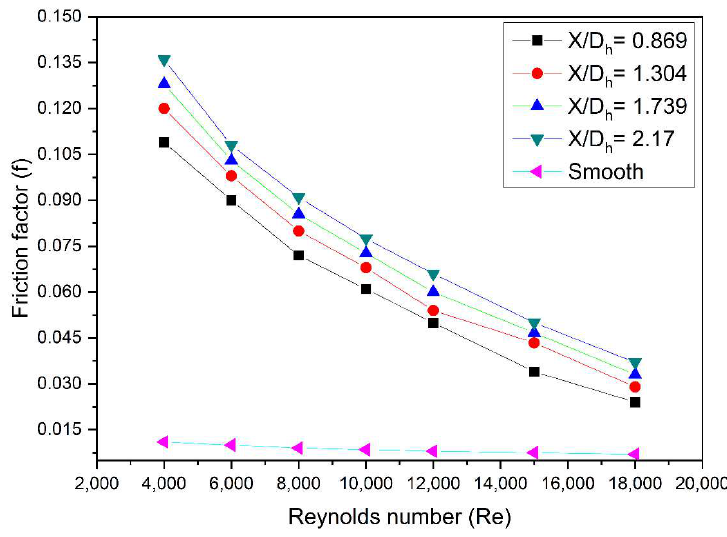
Figure 10. (cid:16) variation with (cid:8)(cid:9) as a function of (cid:24)/(cid:22)